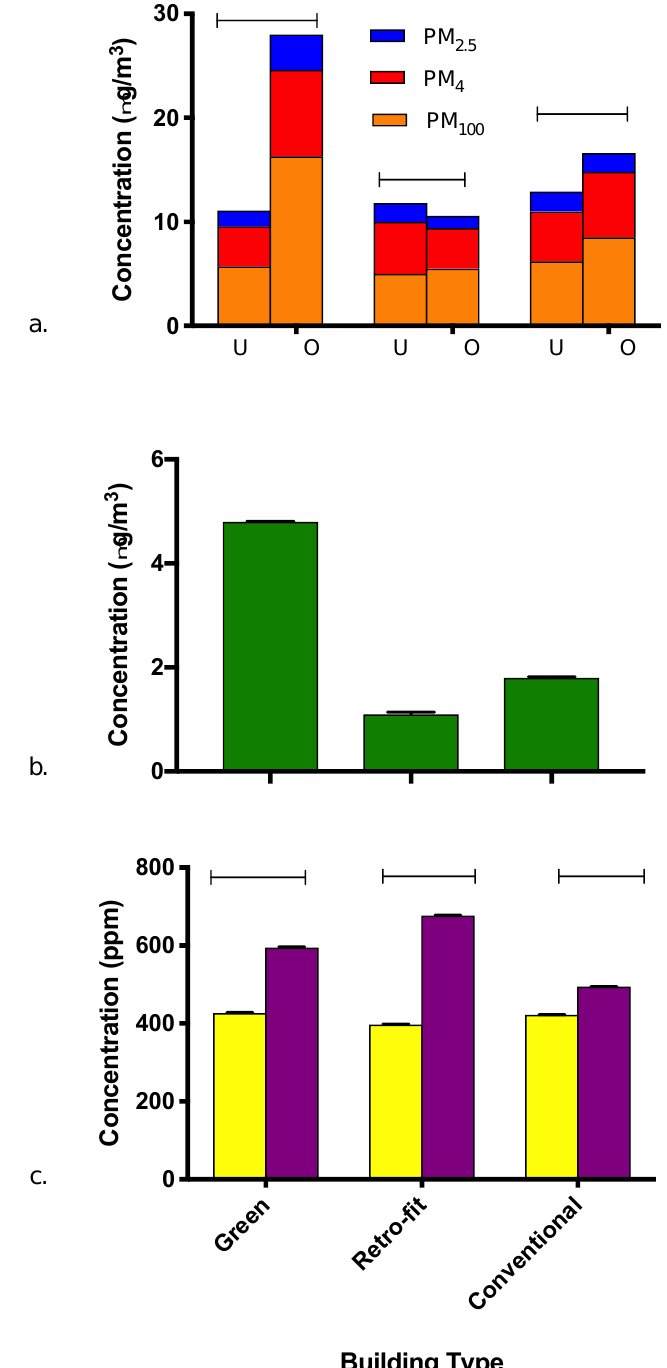
Figure 3. Indoor air quality measures by building type and occupancy: ( a ) airborne concentrations of PM 100 , PM 4 , and PM 2.5 by building and occupancy; ( b ) formaldehyde concentrations by building; and ( c ) CO 2 concentrations by building and occupancy. Because formaldehyde concentrations were not statistically significant between occupied and unoccupied, only an aggregated value by building is presented. Occupied status is represented as (U) unoccupied (left bar) and (O) occupied (right bar) in panels a and c.